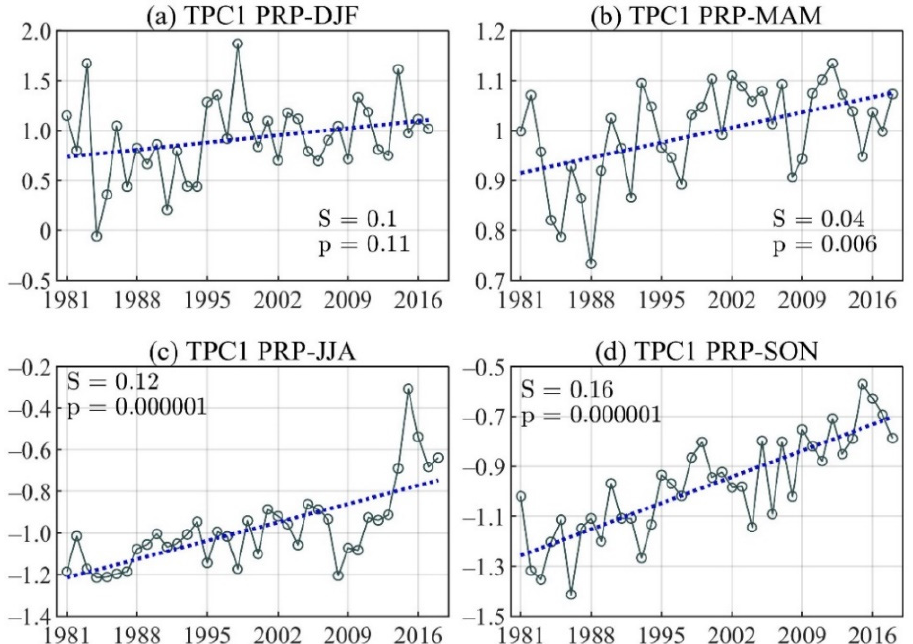
Figure 4. The linear trend of the principal component time series for the first trend mode-EOF of total precipitation (PRP) during ( a ) December–February (DJF), ( b ) March–May (MAM), ( c ) June–August (JJA), and ( d ) September–November (SON).